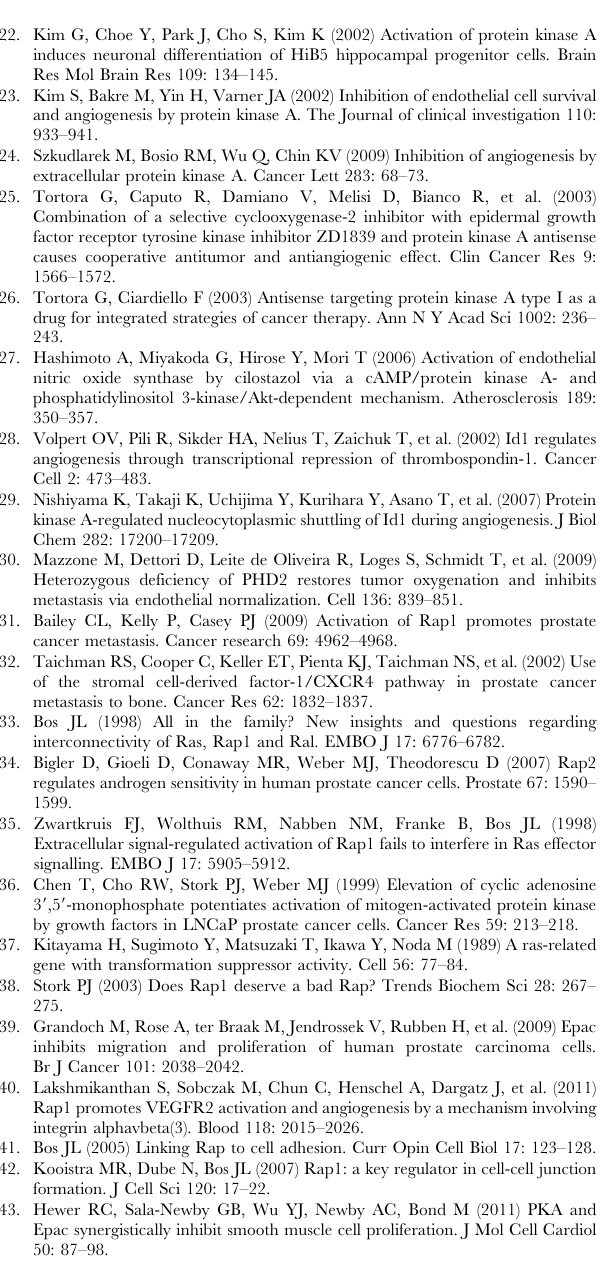
CoCl 2 . Prior to CoCl 2 administration, cells were pretreated with either buffer or myristoylated PKI as described for H89. Figure S8 6BzcAMP inhibits secreted VEGF levels and myristoylated PKI reverses it. PC3-cRap1 cells were untreated or exposed to 6BzcAMP (6Bn) overnight or treated with CoCl 2 as described in Methods. Prior to CoCl 2 administra- tion, cells were pretreated with either buffer or myristoylated PKI.